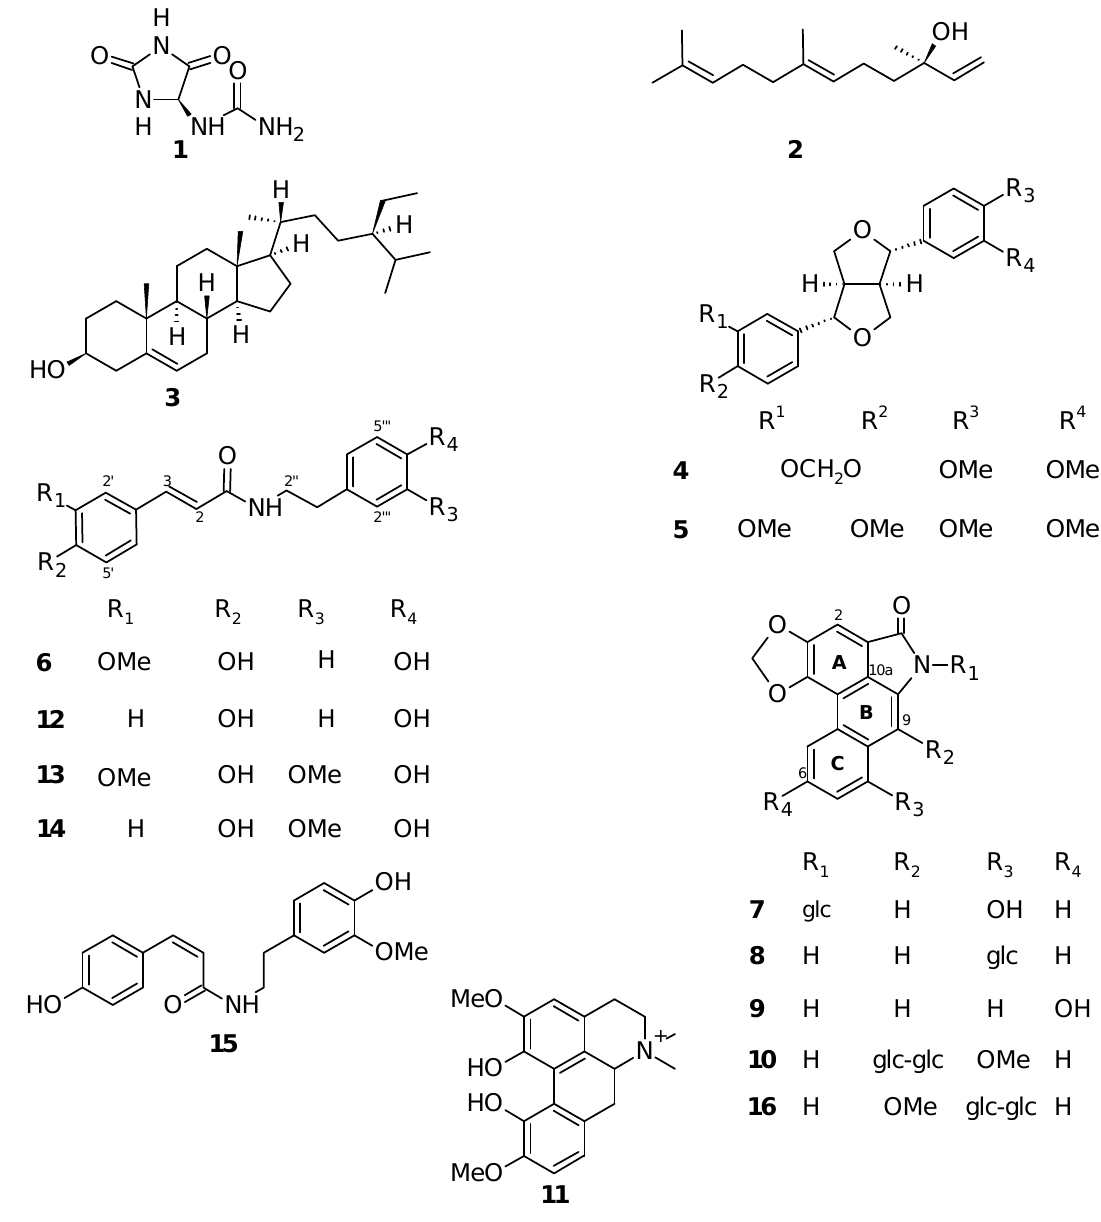
Figure 1. Chemical structures of compounds 1 – 16